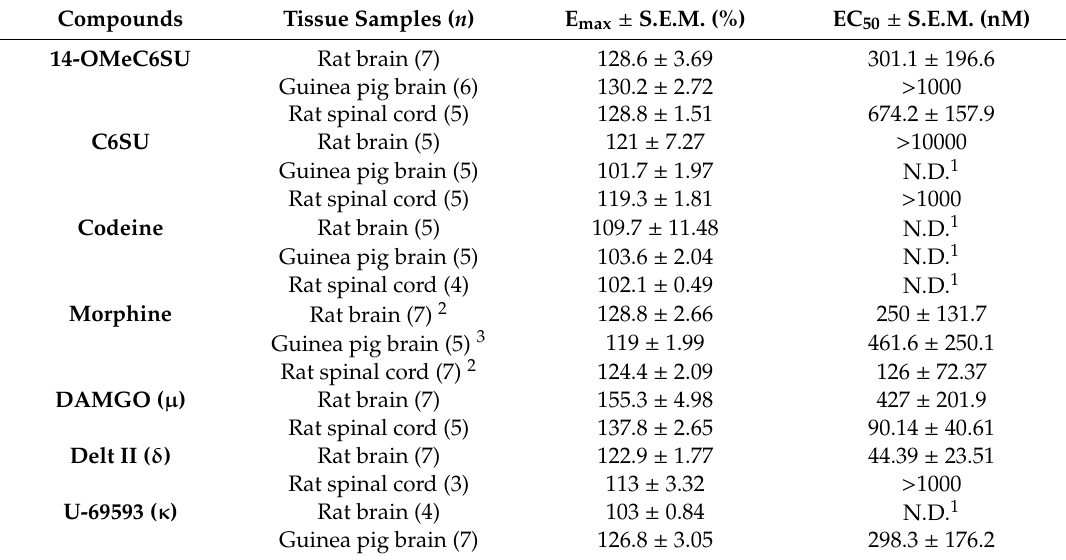
Table 2. Maximum G-protein e ffi cacy (E max ) and potency (EC 50 ) of 14-methoxycodeine-6- O -sulfate (14-OMeC6SU) compared to codeine-6- O -sulfate (C6SU) and codeine in [ 35 S]GTP γ S binding assays in rat or guinea pig brain and rat spinal cord membrane homogenates. The table also indicates the µ -, δ - and κ -opioid receptor specific agonists DAMGO, deltorphin II (Delt II) and U-69593, respectively. Compounds